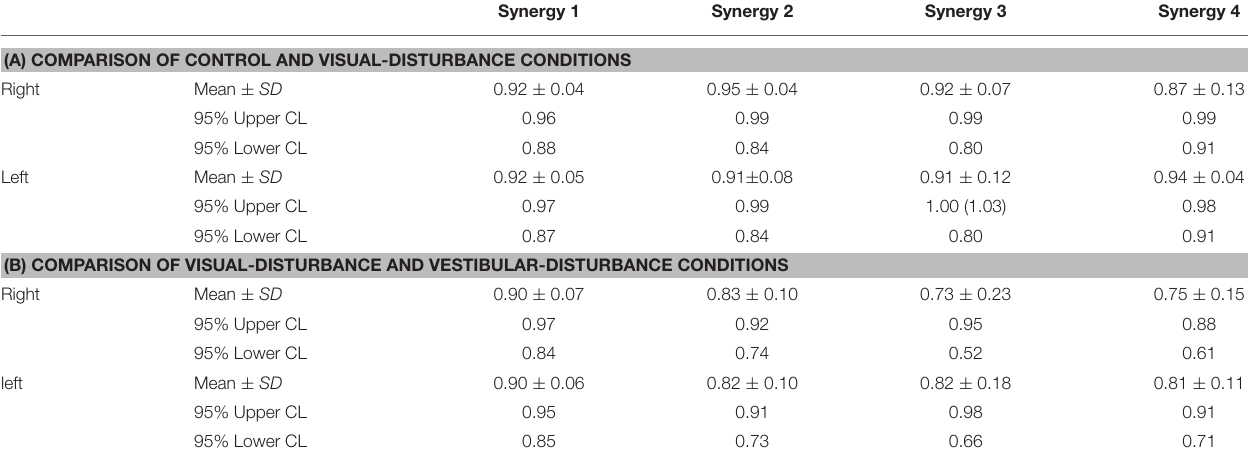
TABLE 1 | Similarity of spatial